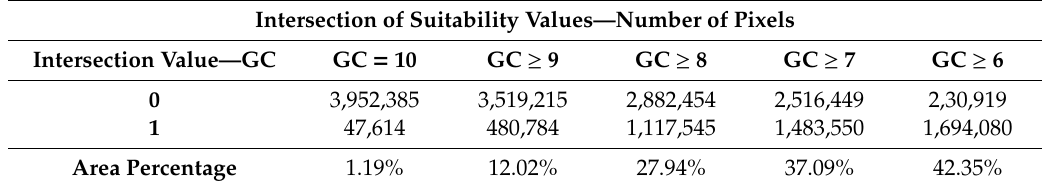
Table 5. Intersection results and percentage of suitable areas from the total area of the